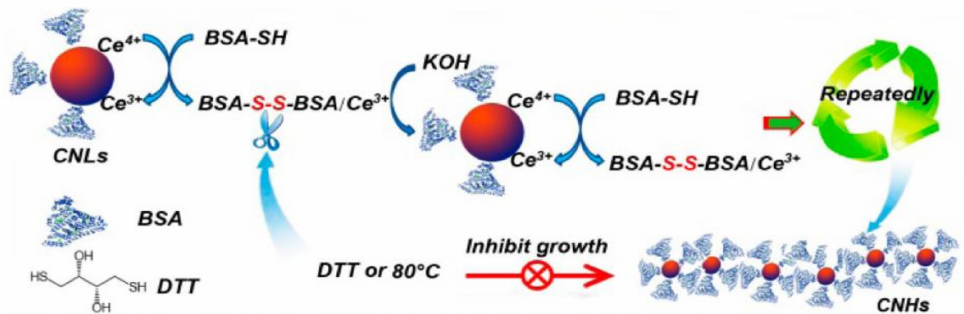
Figure 6. Proposed mechanism for the biomolecular templating effect of albumin on ceria NPs nucleation and growth into nanochains. Reprinted with permission from [45]. Copyright © 2021, American Chemical